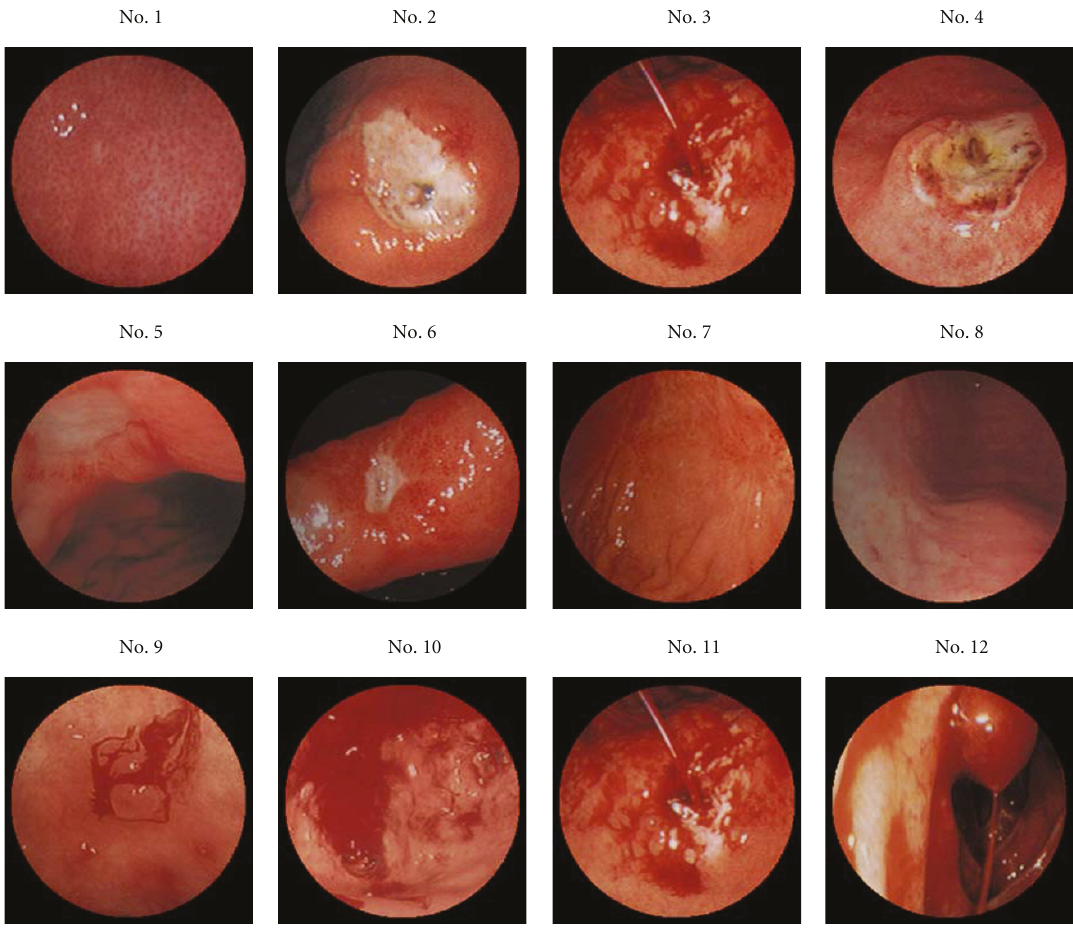
Figure 4: The twelve tested GI